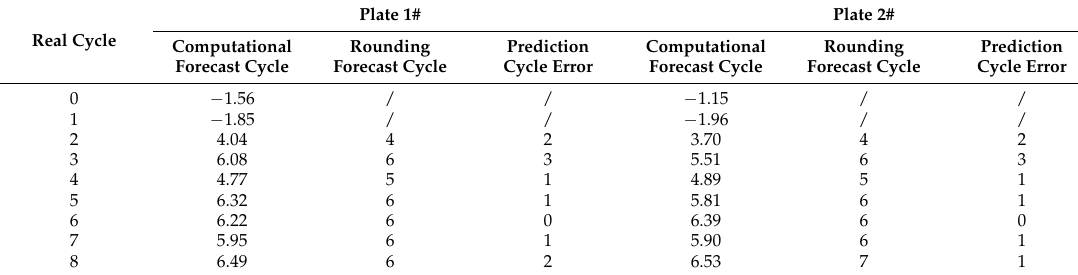
Table 1. Prediction results of degradation kinetics